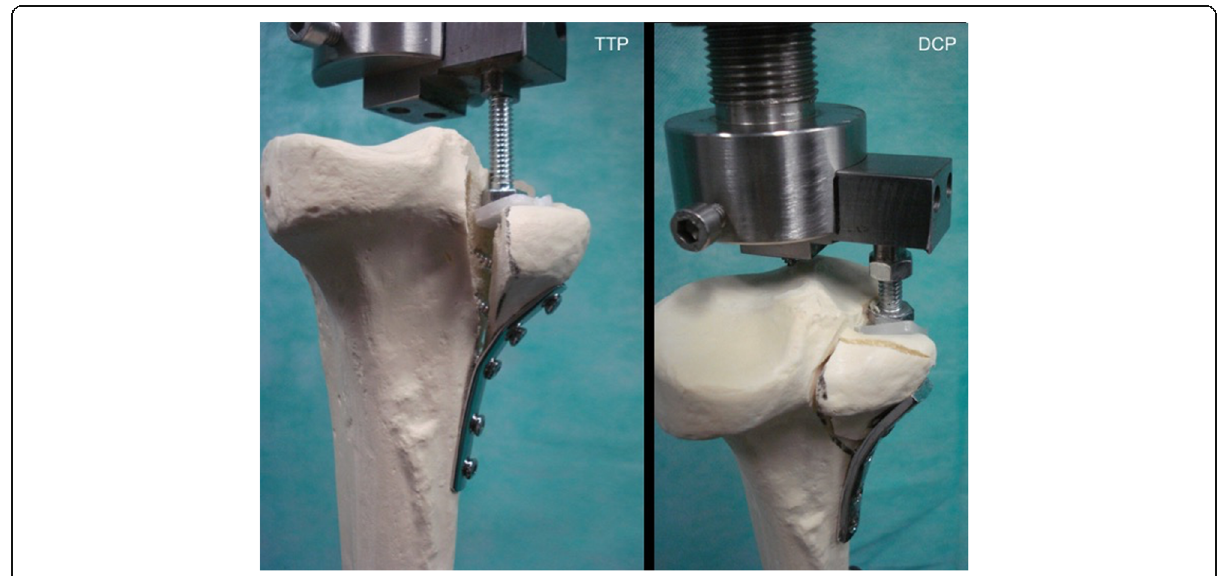
Fig. 7 Mode of failure for the TTP and DCP constructs, represented by one specimen of each experimental